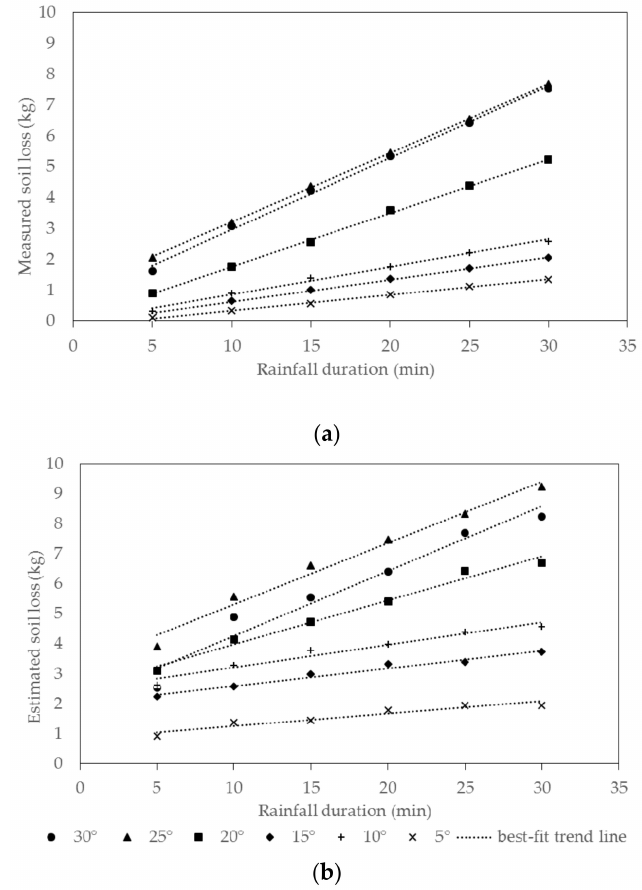
Figure 4. Cumulative mass of soil erosion obtained by: ( a ) the cumulative sediment yields as the measured soil loss; ( b ) the cumulative volume-differences soil loss as the estimated soil